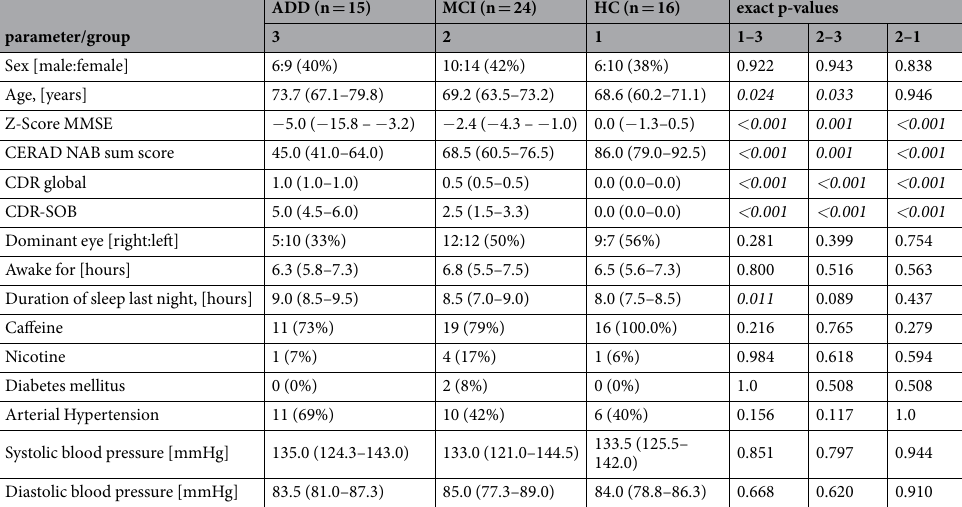
Table 3: “arterial time to reach 30% of max. dilation”, Fig. 3A) and to MCI (p = 0.004; p < 0.02 after correction;